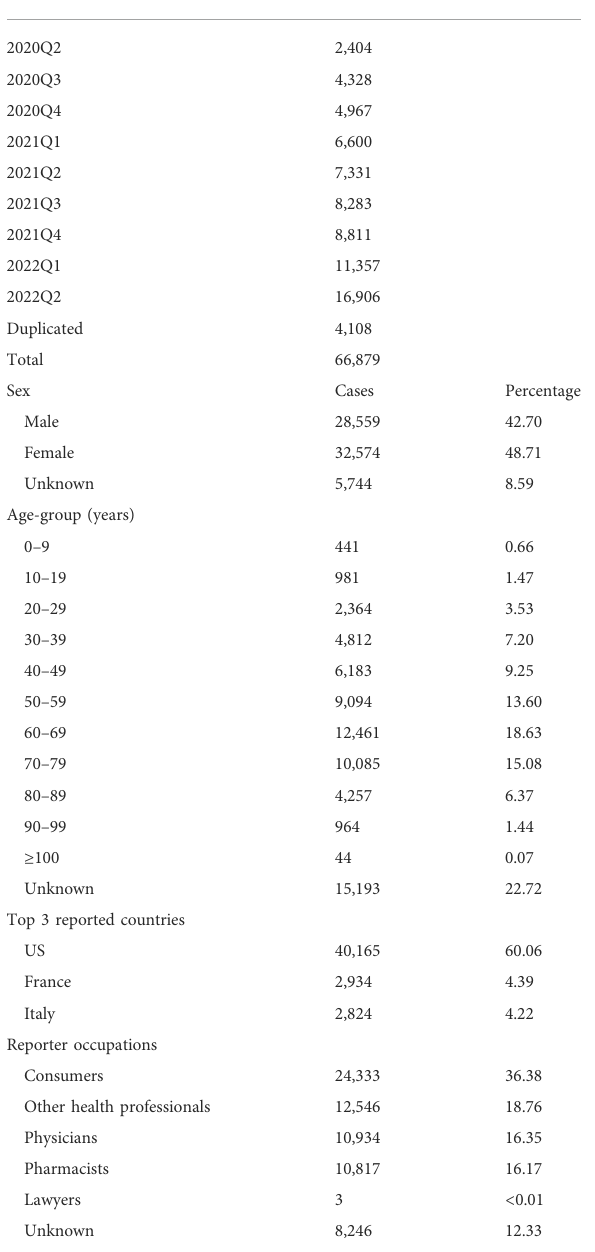
TABLE 3 Demographic data of COVID-19